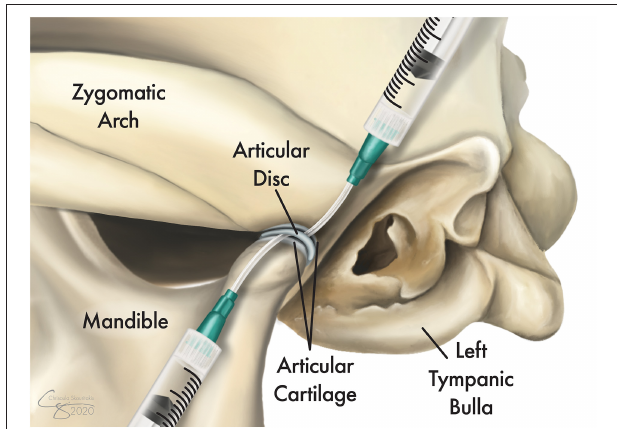
FIGURE 1 | Illustration of the topographic bone and cartilage anatomy of the left temporomandibular joint (TMJ) and its proximity to the tympanic bulla. Following exposure of the lateral aspect of the joint, the TMJ disc is identified and released from its dorsal and ventral attachments to allow full access to both the dorsal and ventral compartments. Tissue samples were obtained from the joint capsule and other grossly affected tissues and were submitted for culture and sensitivity testing as well as for histopathological evaluations. A sterile IV catheter (18G or larger) is inserted into each of the joint compartments and the joint is copiously irrigated with 0.9% sterile